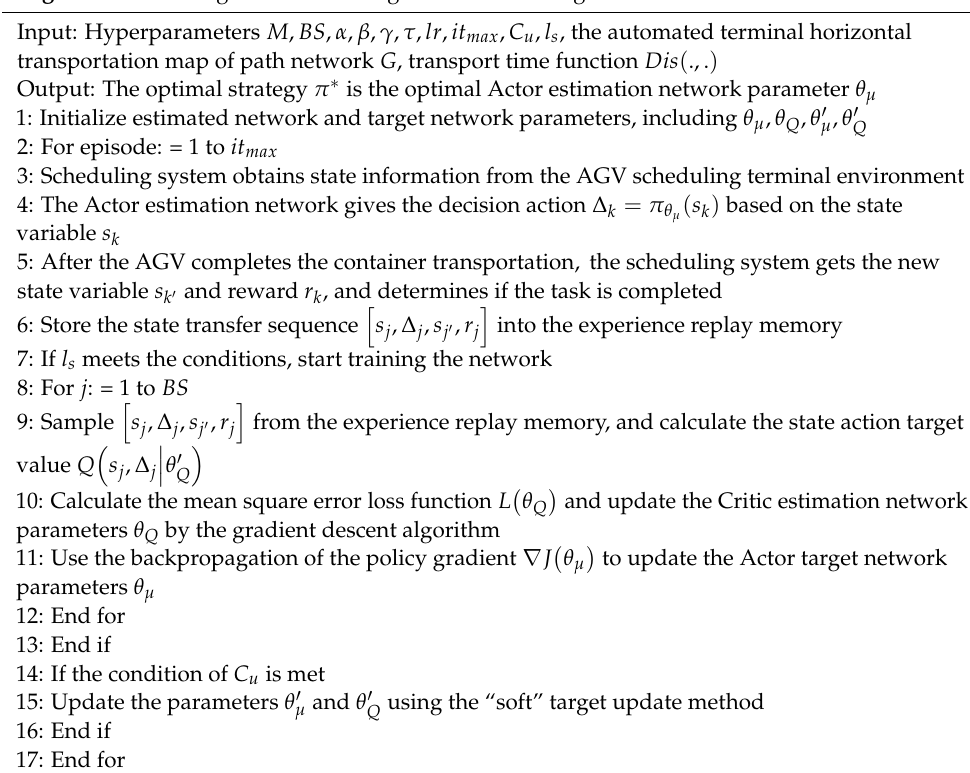
Algorithm 1. Solving AGV scheduling based on CDA